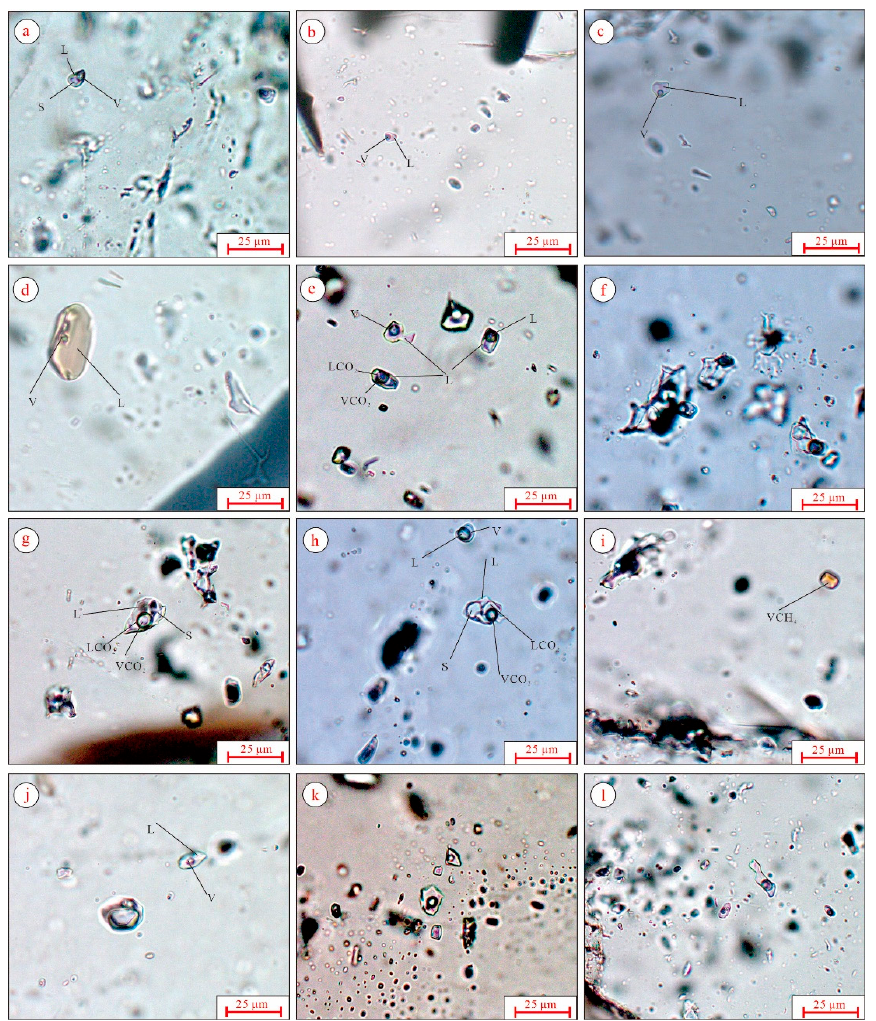
Figure 5. Photomicrographs of fluid inclusions in Reshui Mo deposit. ( a ) Solid-phase or mineral inclusions; ( b ) gas-rich phase inclusion; ( c ) liquid-rich phase inclusion; ( d ) W-type and C-type inclusions; ( e ) S- and W-type inclusions; ( f ) S-type inclusions together with liquid-rich phase inclusions; ( g ) liquid-rich phase inclusions; ( h ) group of irregularly shaped inclusions; ( i ) inclusions with isolated distribution; ( j ) pure gas-phase inclusion; ( k ) irregular and S-type inclusions; ( l ) phenomenon of bottleneck inclusion; L—liquid water; V—gas-phase water; LCO 2 —liquid CO 2 ; VCO 2 —gas-phase CO 2 ; Op—opaque metal minerals; S—rock salt content.